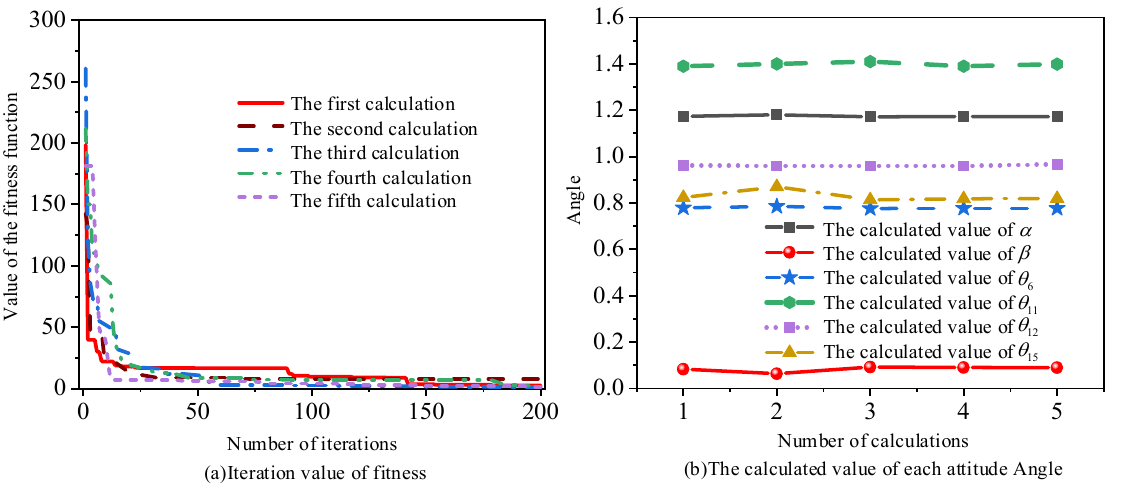
AngleNumber (b)The calculated value of each attitude Figure 6. Experimental results of test I calculated by particle swarm optimization algorithm. ( a ) shows the change of fitness function in the calculation process of particle swarm optimization algorithm for 5 times. ( b ) shows the changes of the optimal values of each attitude Angle obtained by 5 calculations. The experimental data of hydraulic support pose solution test I based on particle swarm optimization algorithm are shown in Table 5. According to the analysis in Table 5, the maximum error ratio of position angle solution is 2.2%, the minimum error ratio is 0.076%, and the average value of maximum error ratio is 0.559%. The solution accuracy can well meet the application requirements. Table 5. TestI of hydraulic support pose solution based on particle swarm optimization algorithm. X α β θ 6 θ 11 θ 12 θ 15 True value 67.2